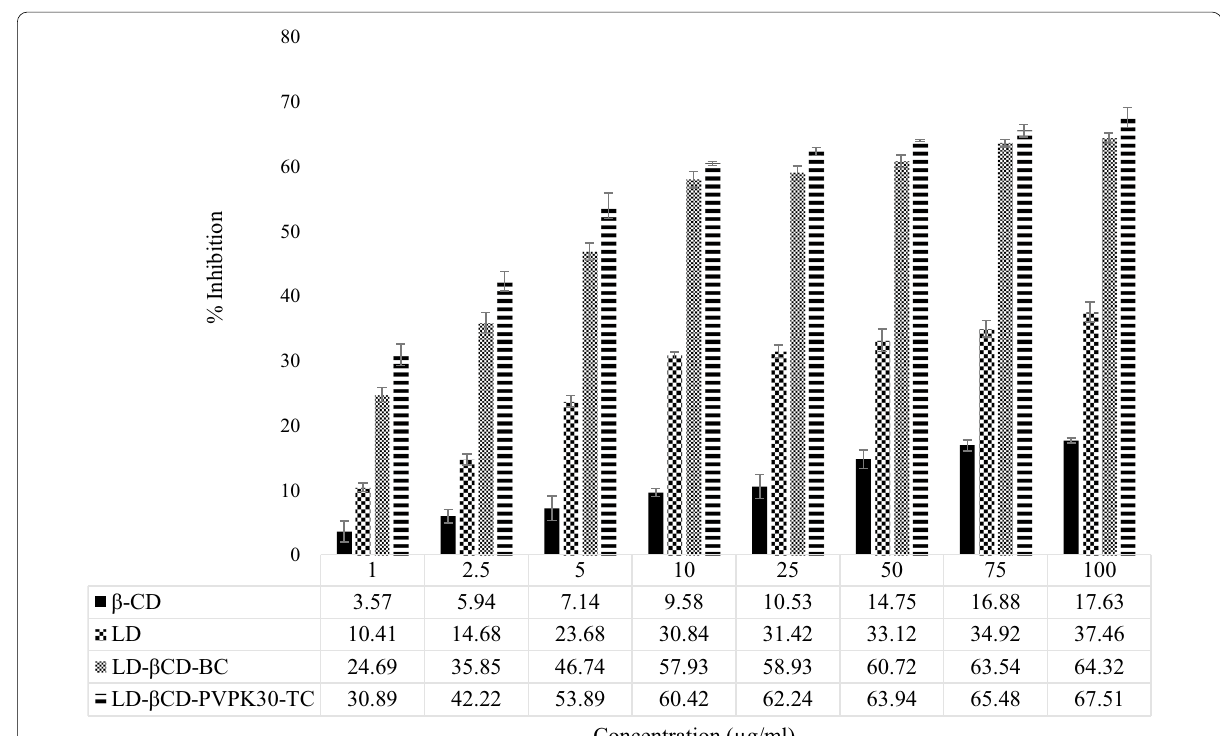
Fig. 14 Percentage inhibition values of β-CD, LD, LD-βCD-BC and LD-βCD-PVPK30-TC with respect to